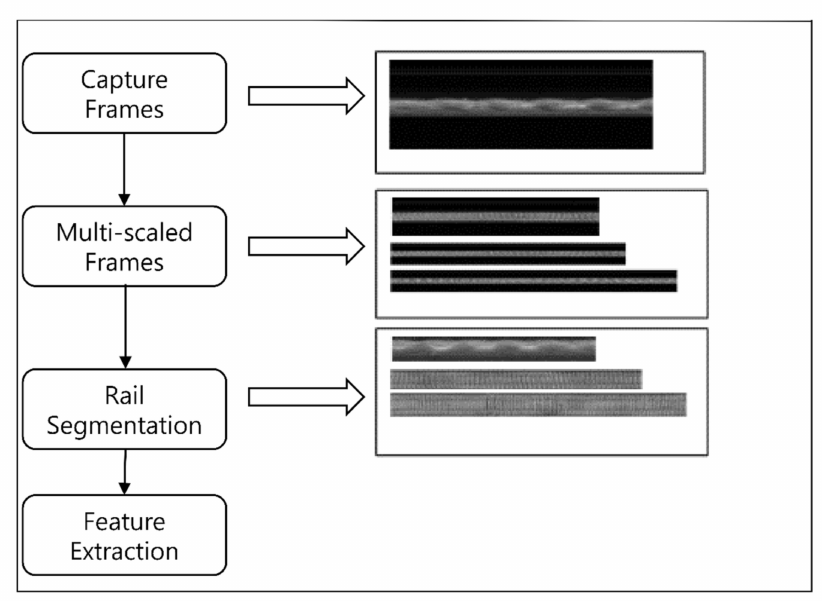
Figure 4. Overview of the preprocessing system.